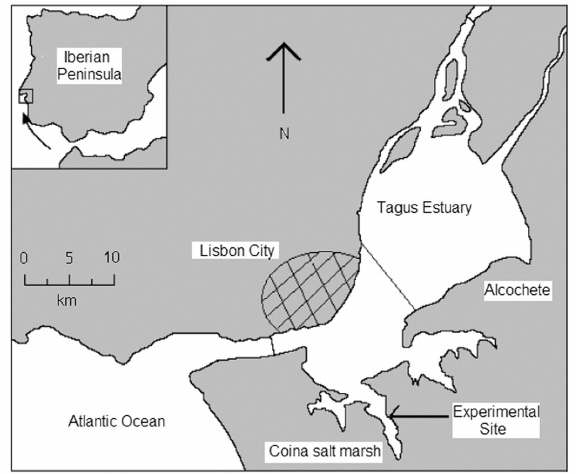
Fig . 1. – Map of the Tagus estuary. An arrow indicates the location where the intertidal experiment took place in the Coina salt marsh. The three transversal lines to the estuary axis are